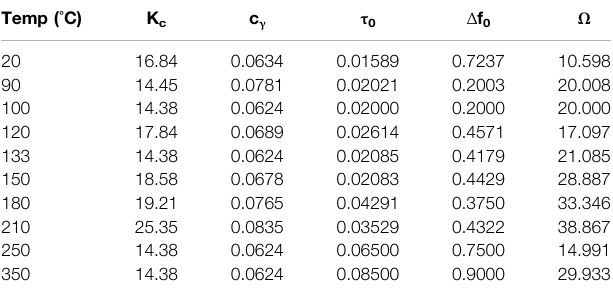
TABLE 3 | Calibrated temperature-dependent parameters of the model.